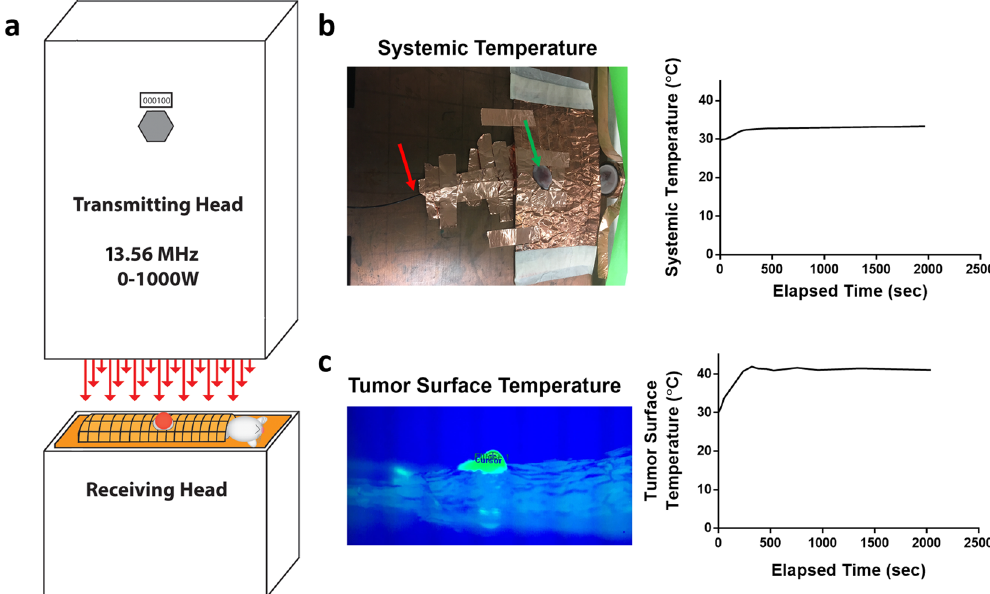
Figure 1. RFT set-up and temperature monitoring. ( a ) Schematic depicting capacitively-coupled radiofrequency (RF) transmitting and receiving head showing mouse orientation and copper blanket shielding. ( b ) Image of mouse grounding and shielding showing exposed tumor (green arrow) and rectally inserted fiber-optic probe (red arrow) used for systemic temperature monitoring. Representative graph to the right shows systemic temperature measurement for a single mouse during an entire RFT session. ( c ) Image from infrared camera showing exposed tumor used for tumor surface temperature monitoring. Representative graph to the right shows tumor surface temperature measurement for a single mouse during an entire RFT session. (Supplemental Figure S1 shows cumulative treatment systemic and tumor surface heating